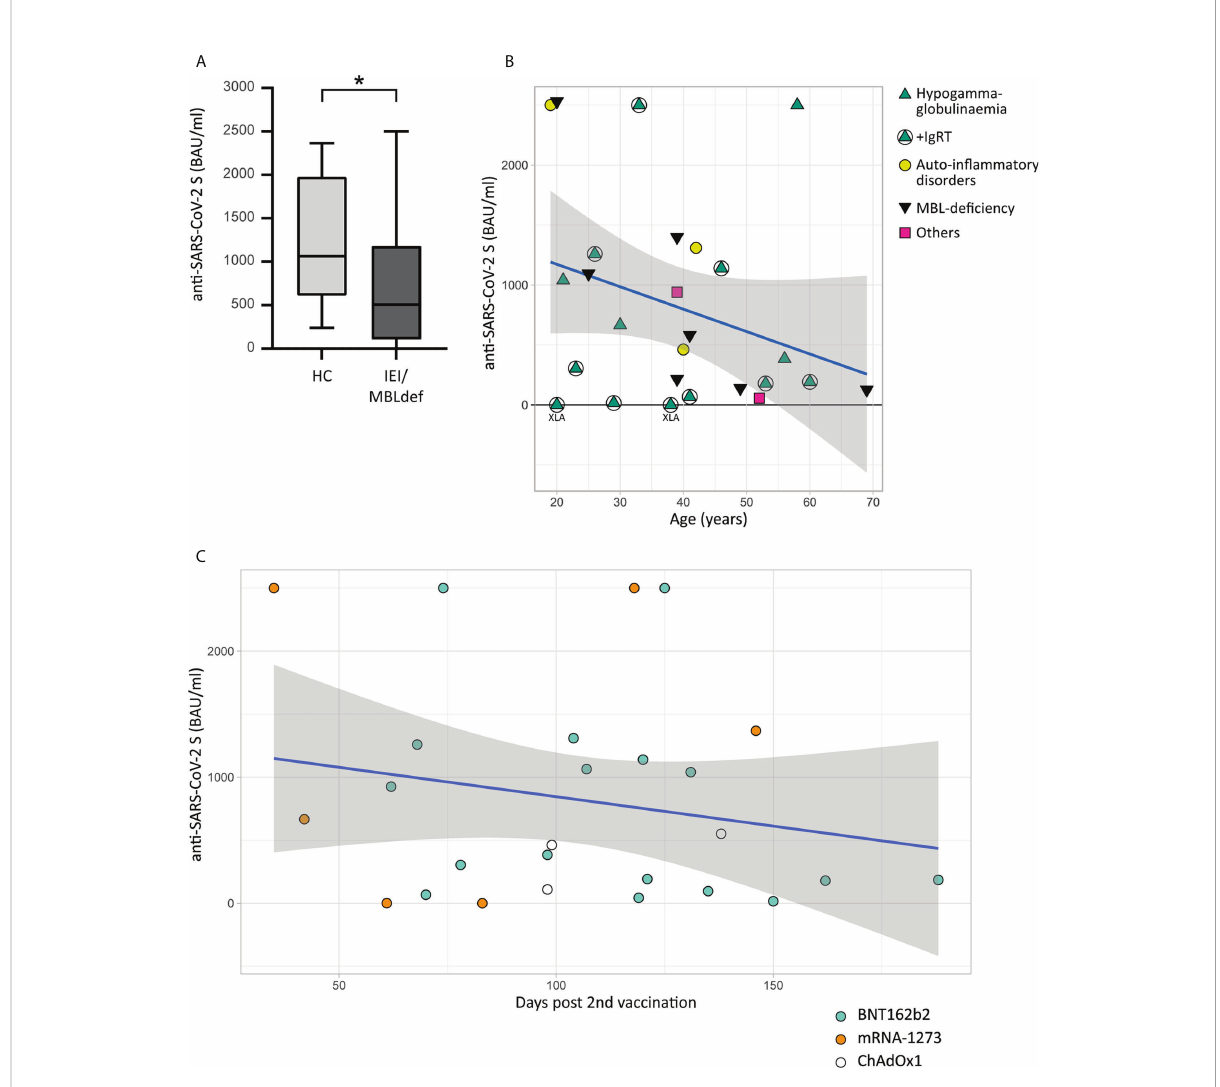
FIGURE 1 Humoral immune response to COVID-19 vaccination. Antibodies to the receptor-binding domain (RBD) of the viral spike (S) protein were determined using an anti-SARS-CoV-2 immunoassay. Values below 0.4 BAU/ml were de fi ned as 0. (A) . Boxplot with IQR and maximum and minimum values whiskers. Comparison of anti-SARS-CoV-2 S levels of 26 matched healthy controls and the IEI/MBLdef group consisting of 26 patients. The asterisk (*) indicates a p<0.05. (B) Scatter plot of antibody levels to the RBD of the S protein (Y-axis) of 26 patients grouped into four classes and the age of the patients (x-axis) in years with a linear regression line including a 95% CI. Green triangles: patients with hypogammaglobulinemia. Patients receiving IgRT are marked with circles. Yellow circles: patients with auto-in fl ammatory disorders. Black inversed triangles: patients with MBL de fi ciency. The patient groups were de fi ned by their predominant serological results as described in Table 2. Patients number 15 and 19 are highlighted with pink squares. The two patients with XLA showed values of anti-SARS-CoV-2 S antibodies below 0.8 BAU/ml. (C) Scatter plot shows the antibody levels to the RBD of the S protein in relation to time after vaccination of the 26 patients grouped into four classes and the type of vaccine with a linear regression line including a 95%